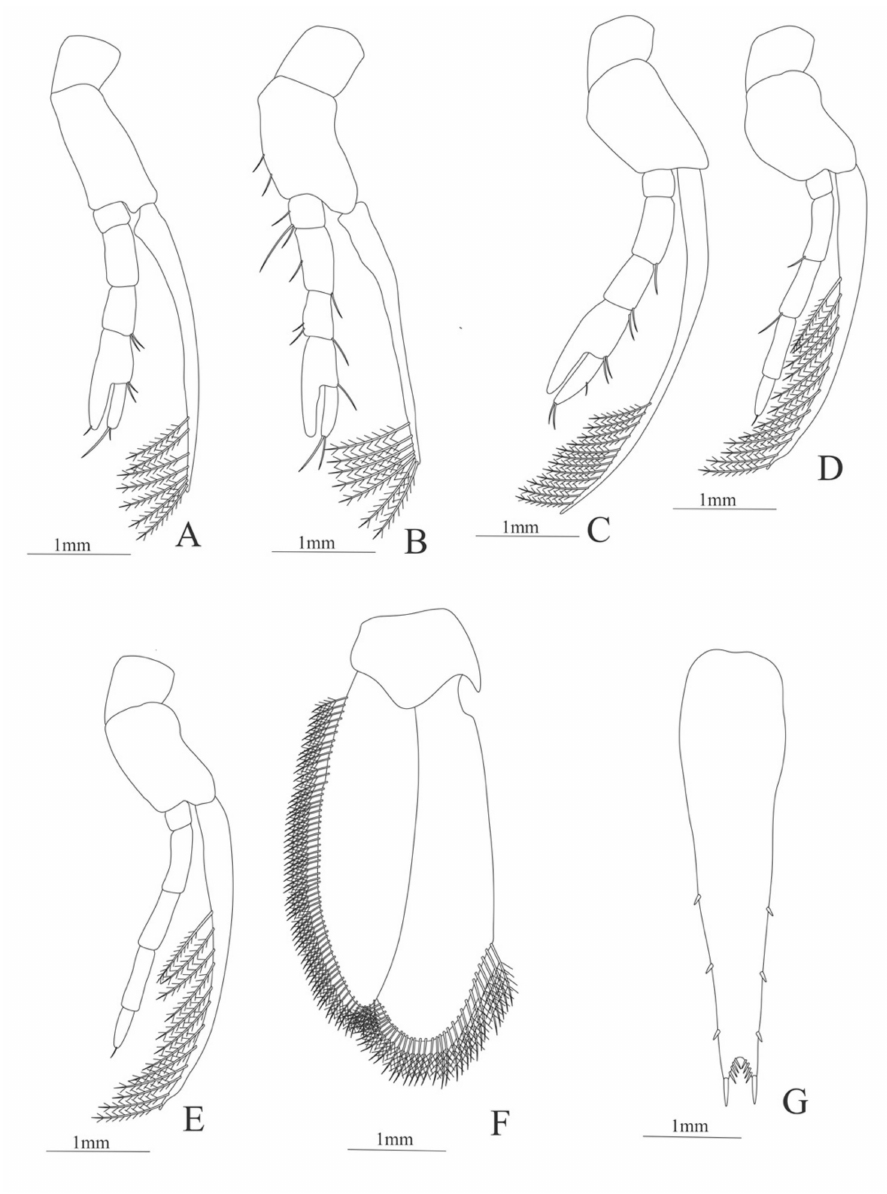
Figure 28. Hemipenaeus carpenteri : ( A ) first pereopod; ( B ) second pereopod; ( C ) third pereopod; ( D ) fourth pereopod; ( E ) fifth pereopod; ( F ) uropods; ( G )